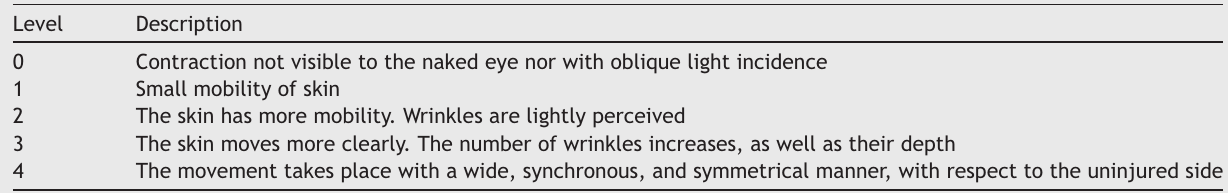
Assessment of facial movement according to Chevalier (1987).